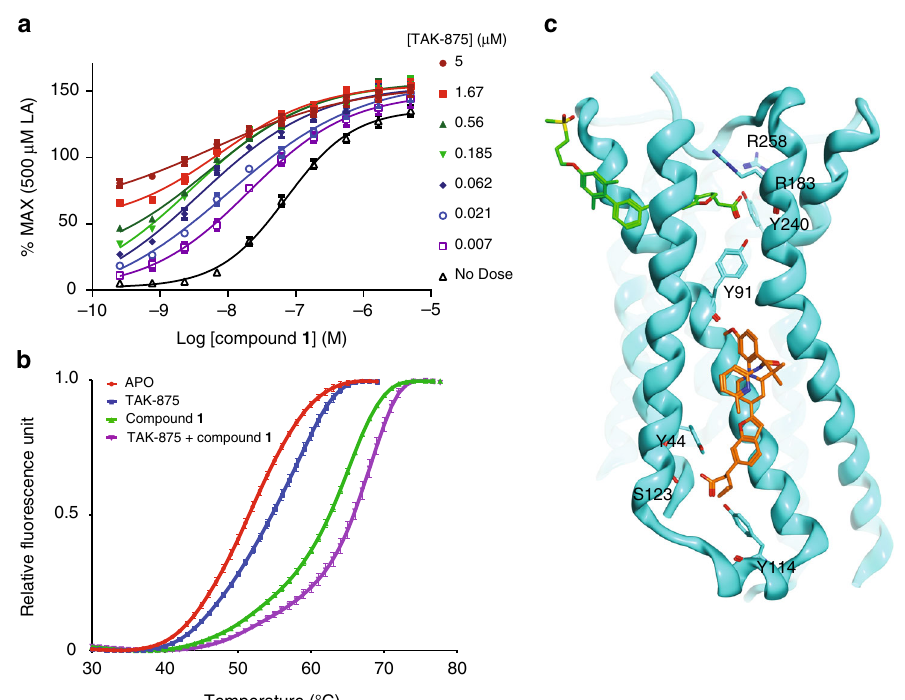
Fig. 8 Positive cooperativity between TAK-875 and compound 1 . a Ca 2+ mobilization assay (FLIPR ® ) of compound 1 in the presence of various concentrations of TAK-875. The presence of TAK-875 shifts the dose response curve of compound 1 to the left in the FLIPR assay (from 72 to 5.8nM), indicating induction of positive cooperativity. N = 4. Error bars indicate s.e.m. The cooperativity composite factor (Log αβ = 1.46) was calculated using the operational model for agonism as described by Wootten et al. 45 , with the slope constrained to 1. Using an average α -factor of 2.1 (averages from Figs. 1a and 8a), the ef fi cacy modulation cooperativity factor ( β ) was calculated to be 14. b Thermal denaturation experiment of unliganded GPR40 ( T m = 51.4°C) and liganded complexes ( T m GPR40-TAK-875 = 58.4 °C; T m GPR40-compound 1 = 65.3 °C; T m GPR40-TAK-875-compound 1 = 68.2°C). N = 3. Error bars indicate standard deviation. Higher T m values re fl ect higher thermal stability. c Structure of GPR40-compound 1 with TAK-875 modeled in site A1. Crystal packing artifact in GPR40-compound 1 looks to have stabilized a somewhat collapsed site A1 that appears incompatible with TAK-875 binding. To model this ligand's binding pose, we removed residues 72 – 86 from transmembrane helix 3 and extracellular loop 1 in GPR40-compound 1 , and modeled those residues back using the corresponding residues in 4PHU. The binding pose of TAK-875 from 4PHU was then superimposed in site A1. Hydrogen bond tethers were added from the carboxylate to the hydroxyl-hydrogen atoms of Tyr 91 and Tyr 240, followed by unrestrained minimization of the ligand, while also allowing the newly modeled region of GPR40 to move unrestrained. The resulting site A1 ends up larger than in our structure and smaller than that of 4PHU